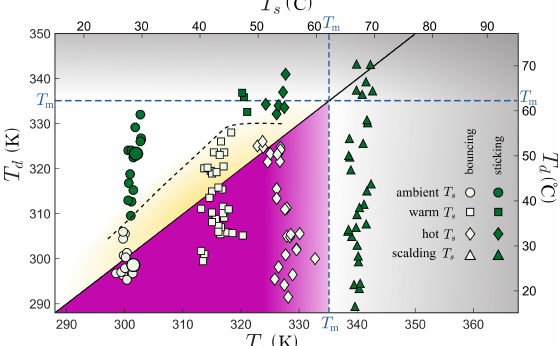
Figure 5. Effect of drop temperature T d and surface temperature T s on the bouncing-sticking transition on the leaf. Surface temperatures are separated into four groups for comparison: ambient (circles), warm (squares), hot (diamonds), and scalding (triangles). The transition between drop bouncing (open symbol) and sticking (closed symbol) is identified by a dashed line as a guide for the eye. The shaded gray region indicates temperatures above a surface melting temperature T m . Below these temperatures, the purple region denotes where drops are colder than the surface, and the lighter yellow region highlights where drops bounce despite being warmer than the